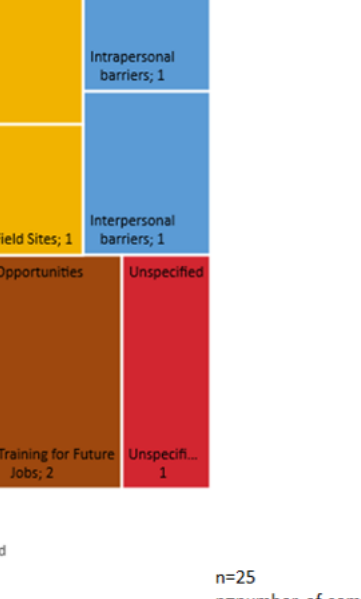
fostering interpersonal relationships. Three subcodes